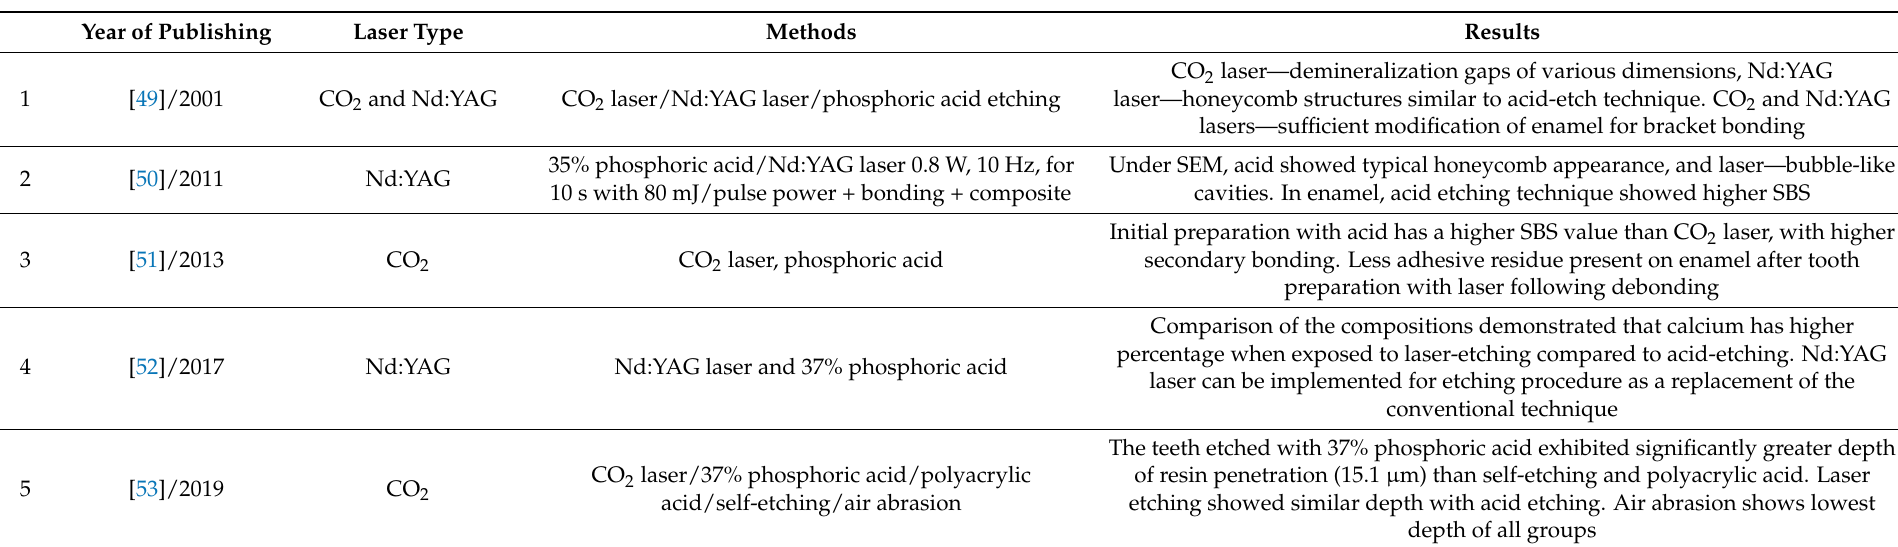
Table 4. Publications investigating other lasers for etching the enamel